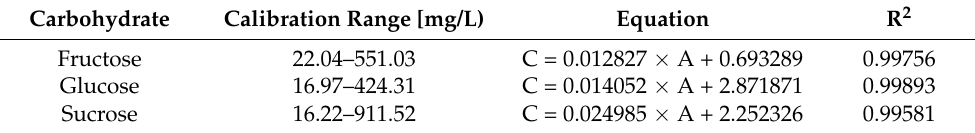
Table 4. Calibration details.